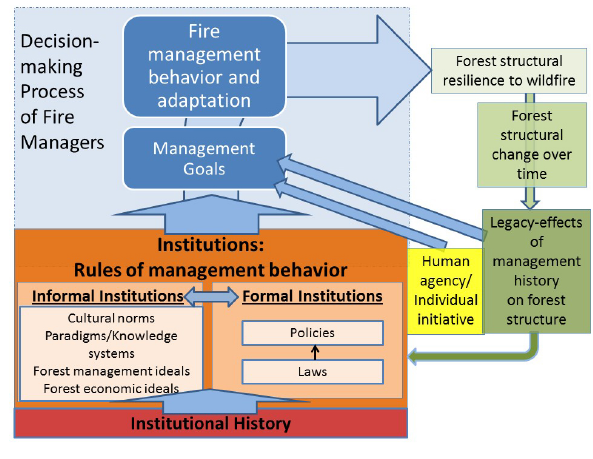
Fig. 2. Conceptual model of social subsystem of fire-frequent coupled human and natural system, with focus on the array of wildfire institutional influences (formal institutions, informal institutions, institutional history) on management